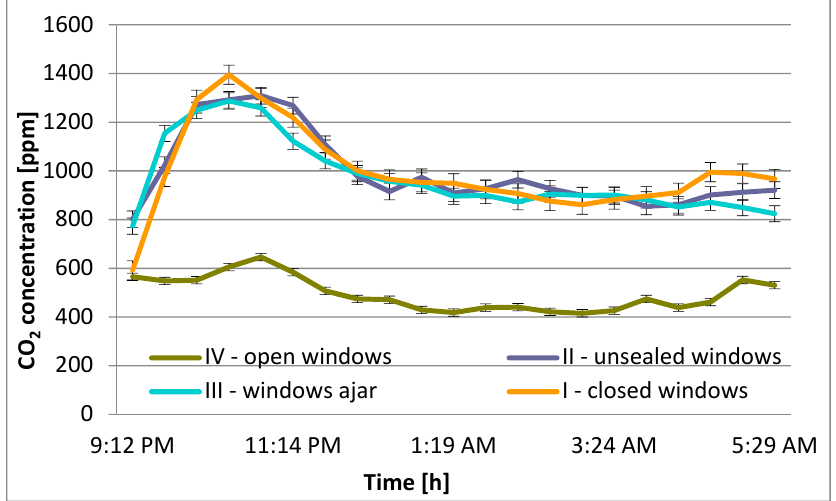
Figure 2. Concentration of carbon dioxide in the bedroom (own